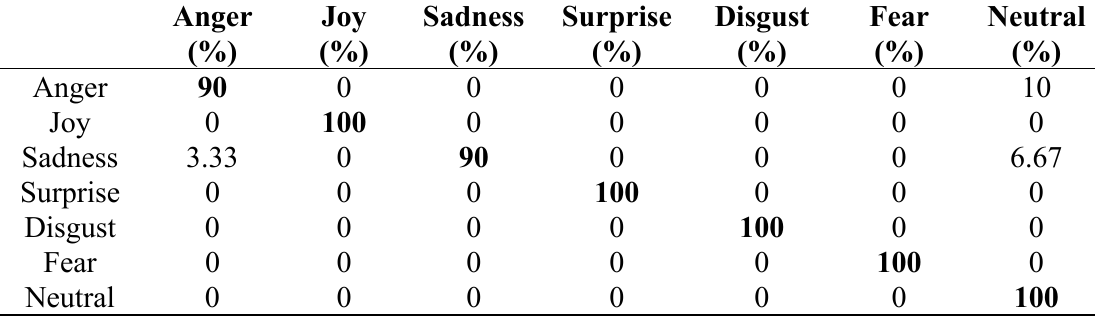
Table 4. Confusion matrix of recognition results of SRC with LBP features.